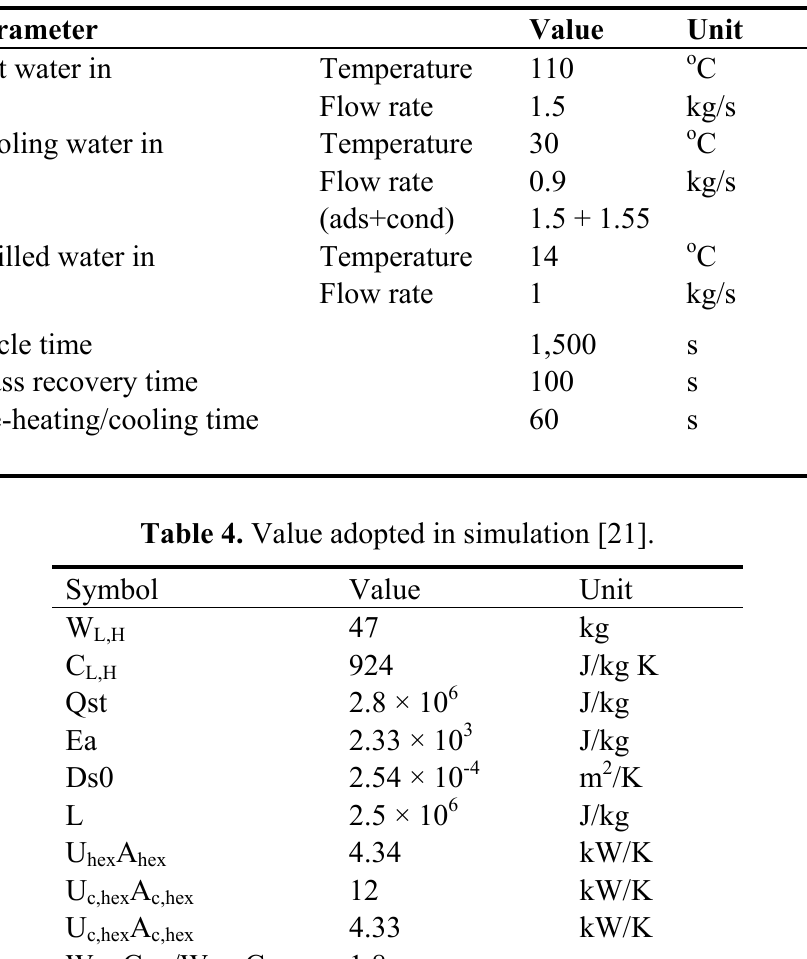
Table 3. Standard operating conditions.